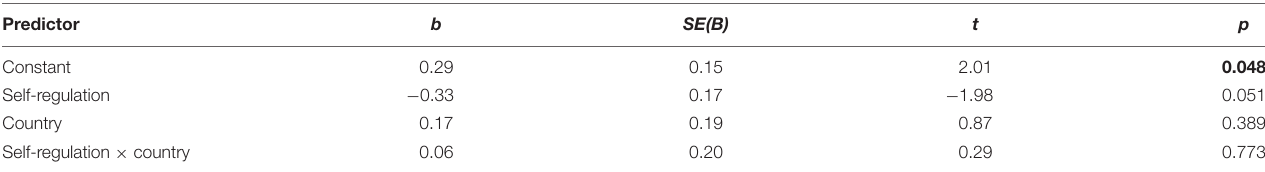
TABLE E1 | Linear model of predictors of multiplication RT in students of Human